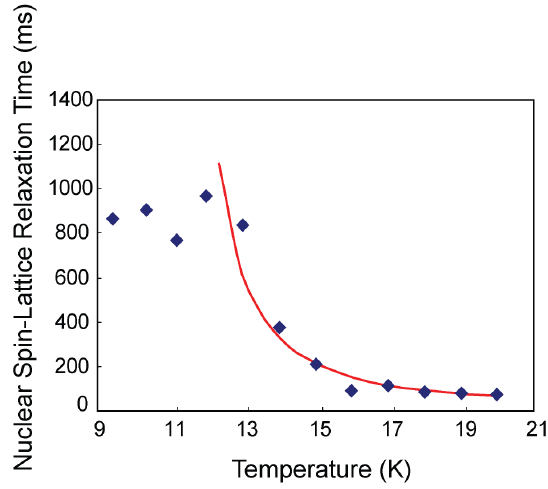
Figure 9. (Color on line) Variation of the nuclear spin-lattice relaxation time with temperature at high temperatures. The solid line (red) is a fit for a thermal activation of 73 ± 3 K and an intrinsic turneling rate of 1.5 × 10 11 s −1